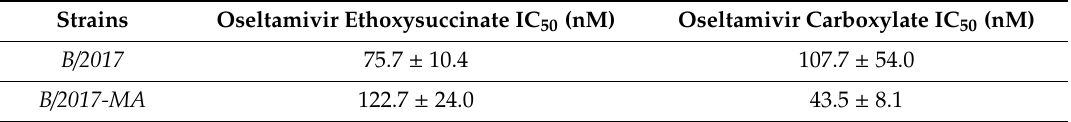
Table 1. Assessment of influenza B viruses in neuraminidase (NA) enzyme inhibition